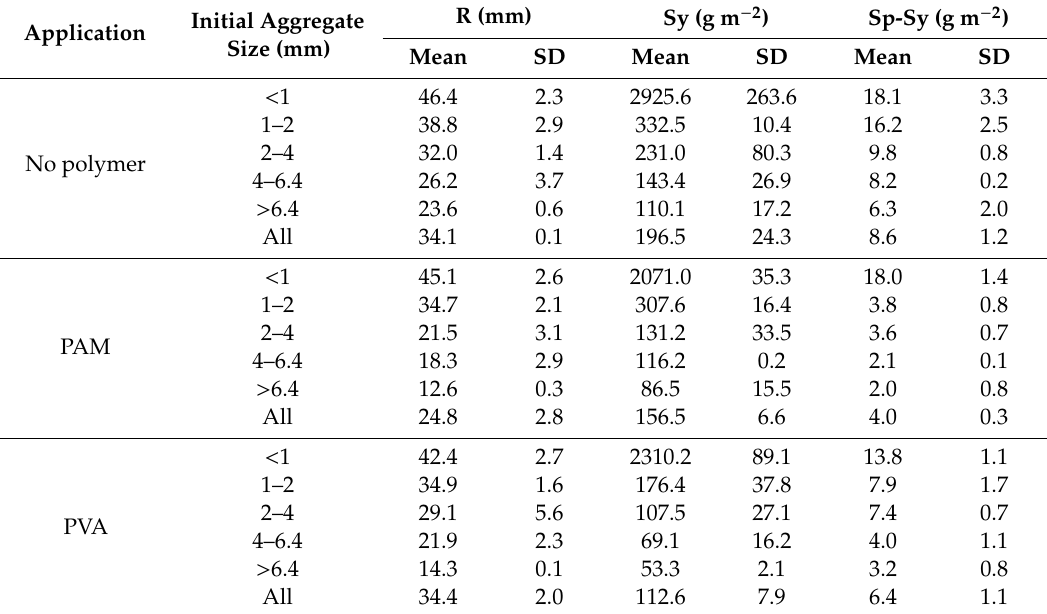
Table 2. Mean values of soil and water losses under the first simulated rainfall. Application